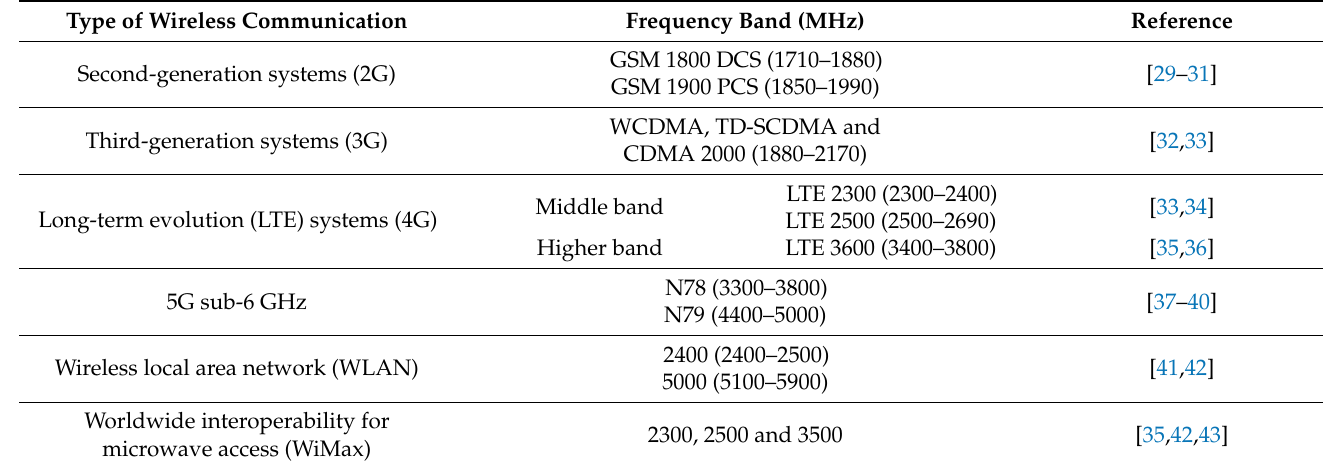
Table 1. Frequency bands for several wireless communication